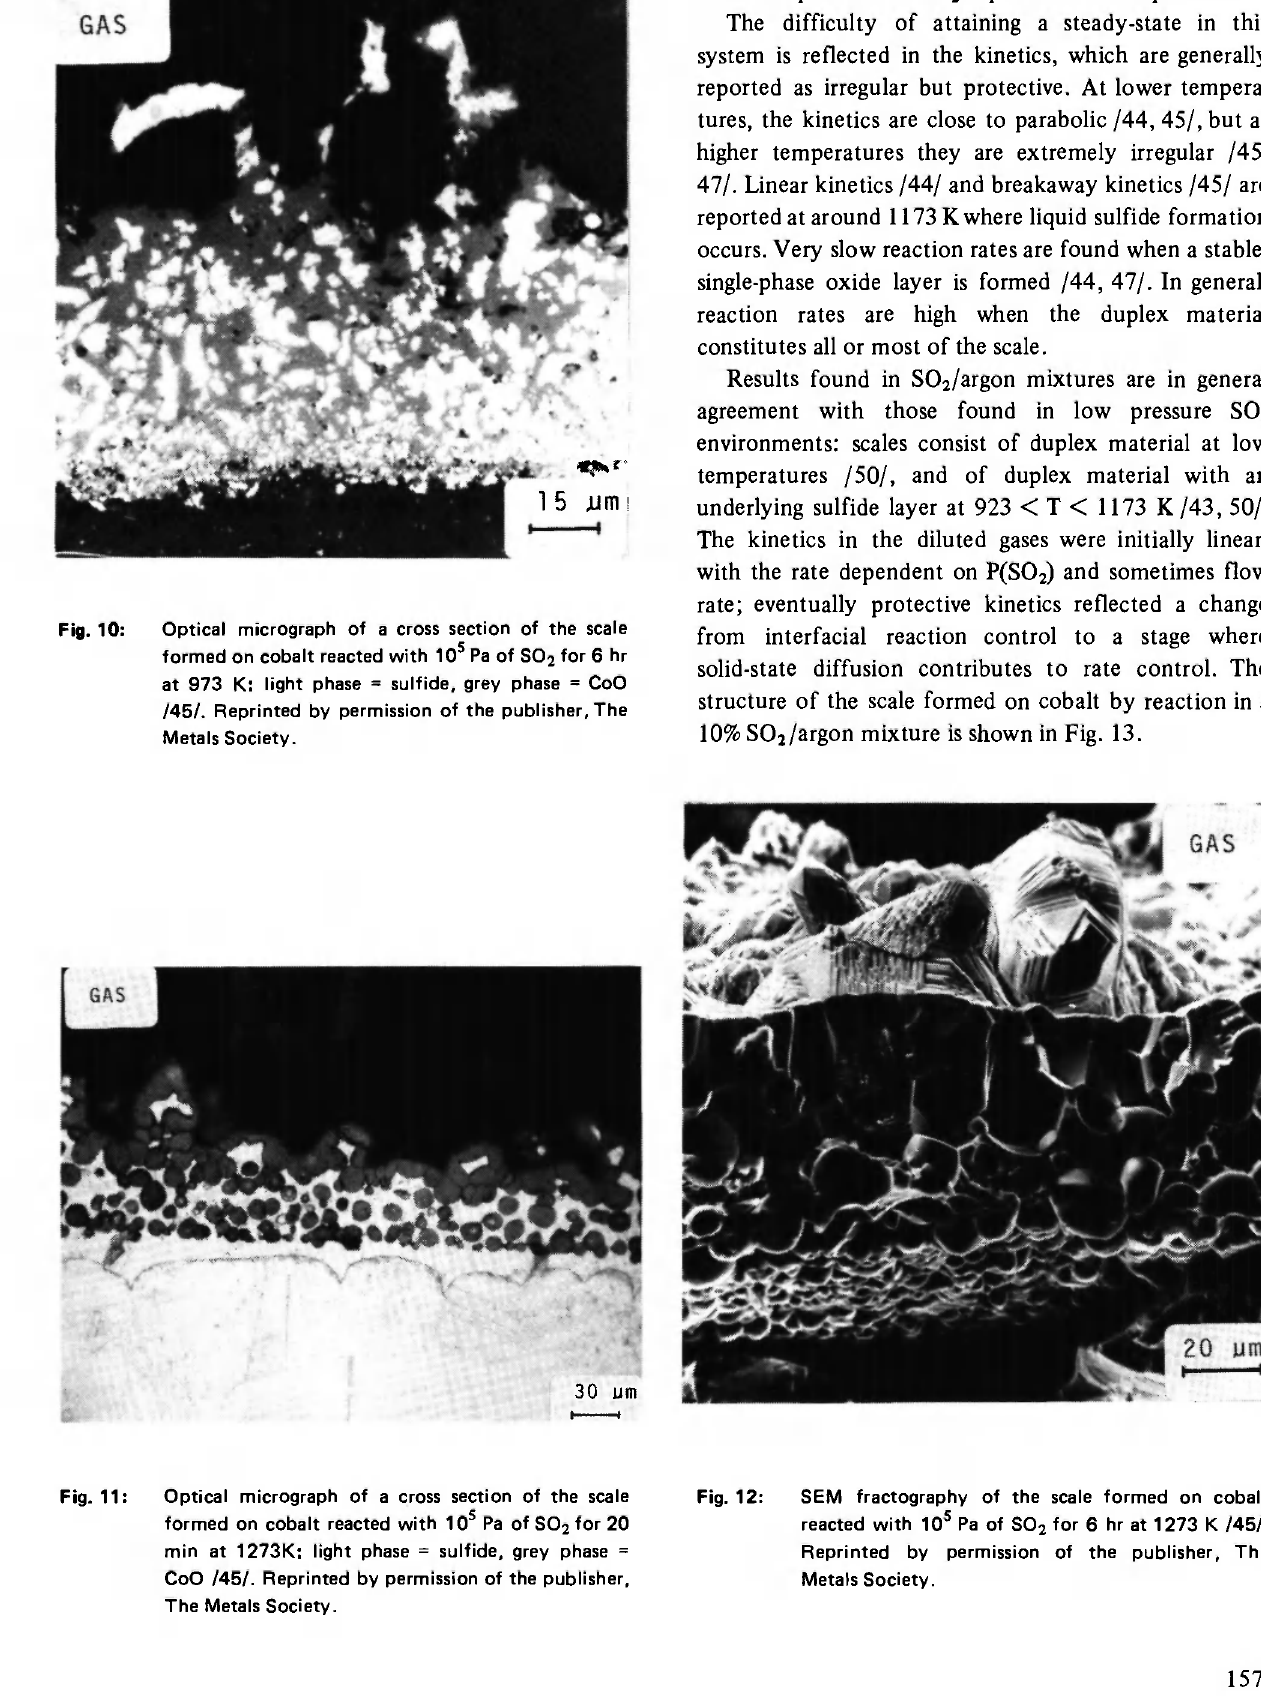
Fig. 11: Optical micrograph of a cross section of the scale formed on cobalt reacted with 10 S Pa of S0 2 for 20 min at 1273K: light phase = sulfide, grey phase = CoO /45/. Reprinted by permission of the publisher, The Metals Society.